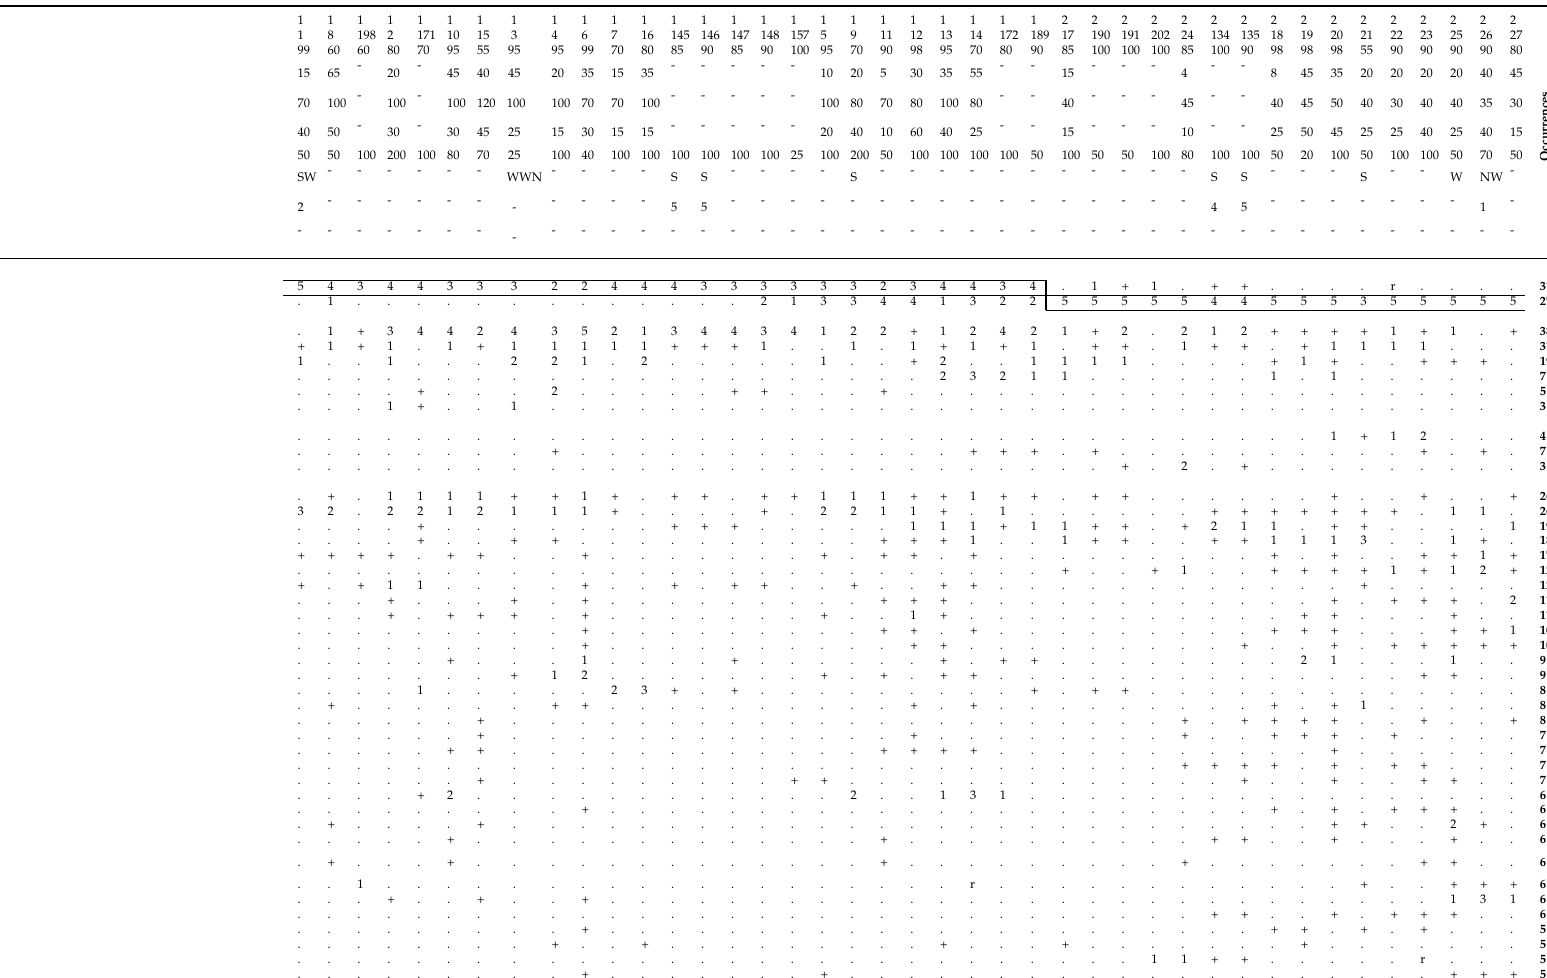
Table A2. Phytosociological relev é s from the Island of Capo Passero (SE Sicily)—shrub vegetation. Cluster